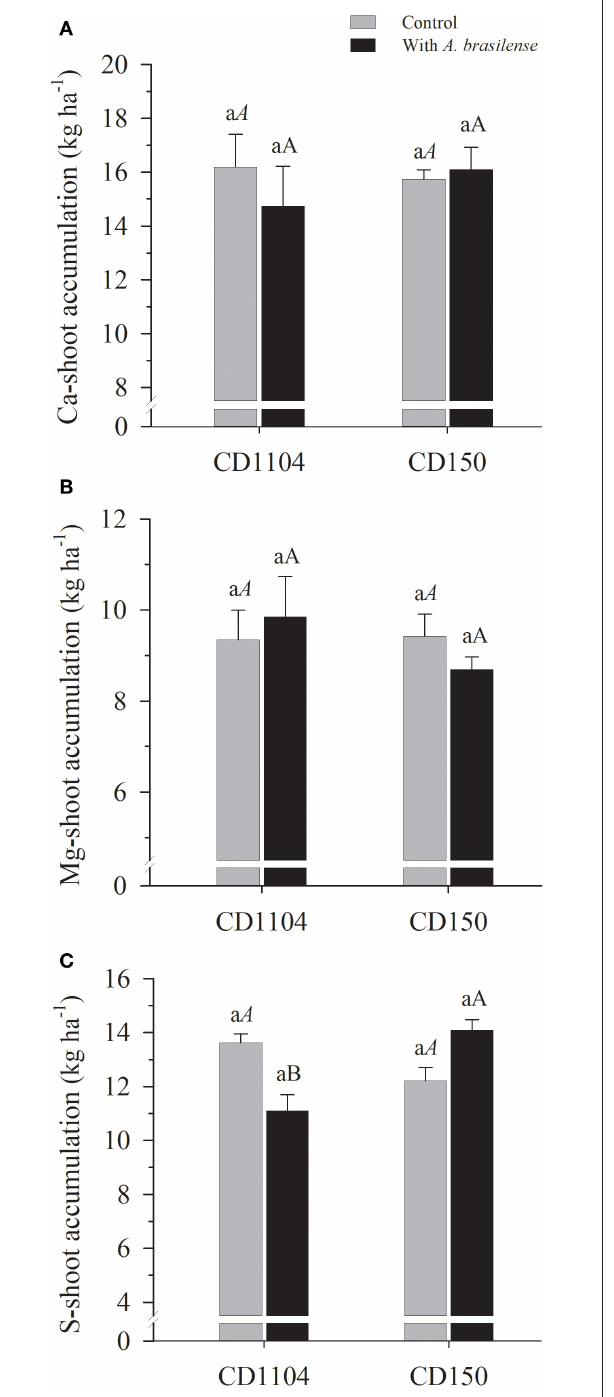
FIGURE 4 | Effects of inoculation with A. brasilense on the shoot of the wheat cultivars CD1104 and CD150 in the nutritional accumulation of B (A) , Cu (B) , and Fe (C) . Different letters indicate difference between means according to a Tukey test ( p ≤ 0.05). Lowercase letters correspond to cultivars within each inoculation level, and uppercase letters correspond to inoculations within each cultivar level. Identical letters do not differ from each other according to a Tukey test ( p ≤ 0.05). CV (%) = 8.7 (A) , 9.3 (B) , and 13.9 (C) . Error bars indicate the standard error of the mean ( n = 6